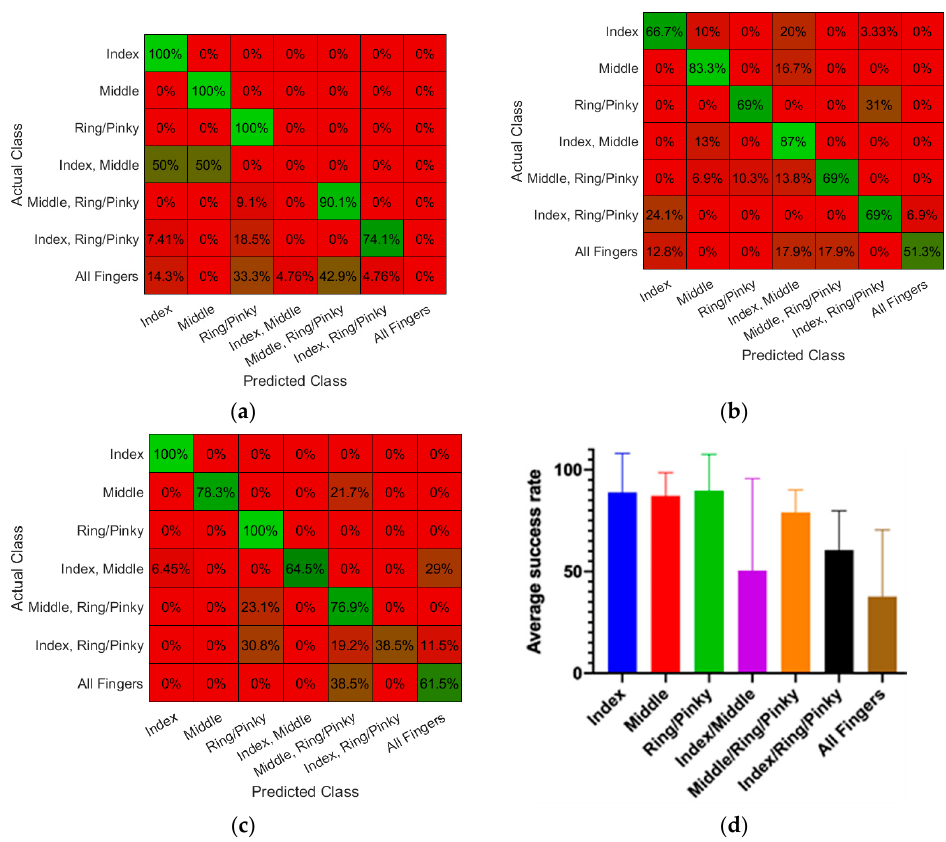
Figure 12. Results of testing the performance of the model implemented for online classification of the gestures: ( a ) Confusion matrix plots for tests with subject 1, ( b ) Confusion matrix plots for tests with subject 2, ( c ) Confusion matrix plots for tests with subject 3, and ( d ) Average success rate of the model in the online classification of the gestures across all test subjects.